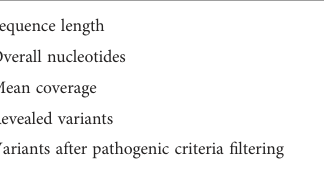
TABLE 3 Properties of the